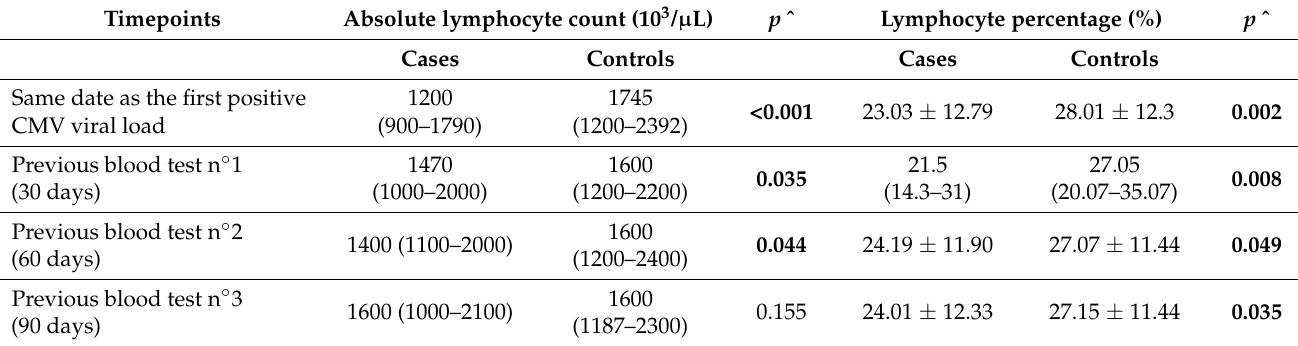
Figure 3. Immunosuppressant drug. The CMV infection rate was lower in the group of patients treated with tacrolimus ( p = 0.021).